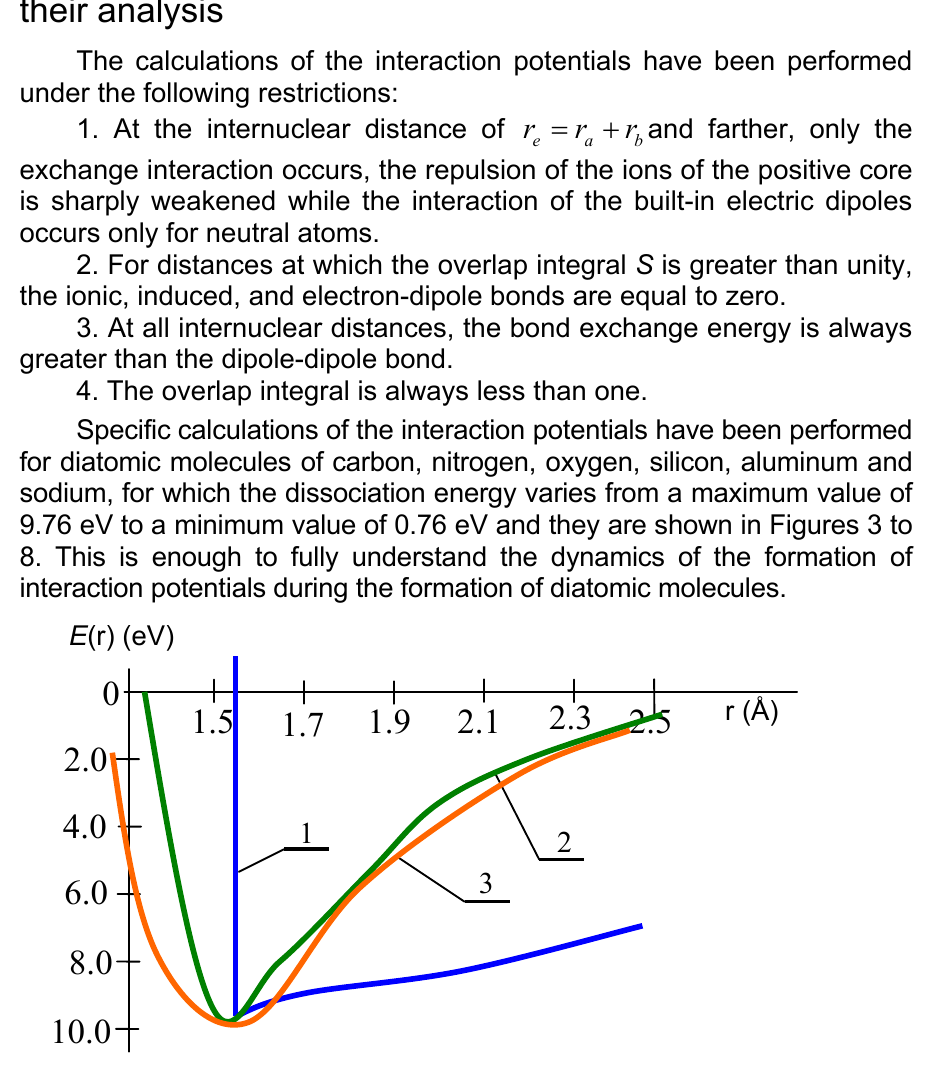
Figure 3 – Interaction potential in the diatomic nitrogen molecule obtained using: 1 - formula (25); 2 - Lennard-Jones formula; 3 - Morse formula Рис . 3 – Потенциал в двухатомной молекуле азота полученный по формуле : 1 - (25); 2 - Леннарда - Джонса ; 3 - Морзе Слика 3 – Потенцијал интеракције у двоатомском молекулу водоника добијен помоћу : 1 - формуле 25, 2 - Ленард - Џонсове формуле , 3 - Морзеове